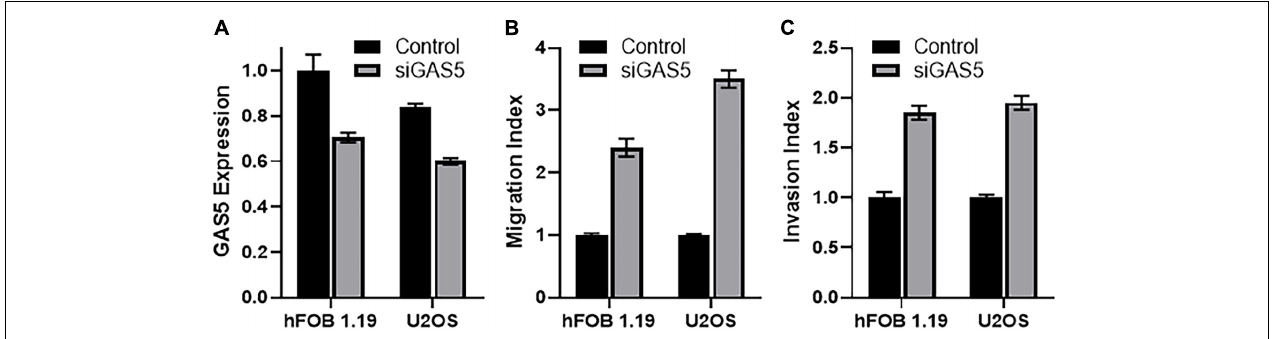
FIGURE 2 | Downregulation of growth arrest specific 5 (GAS5) in osteosarcoma cells affects migration and invasion of cells. (A) GAS5 was silenced by siGAS5 in hFOB 1.19 and U2OS cells, and the resulting effect on (B) migration and (C) invasion was analyzed. Control cells (without GAS5 silencing) were assigned a value of “1,” and the corresponding differences in GAS5-silenced cells are shown. Under all conditions, p < 0.01.